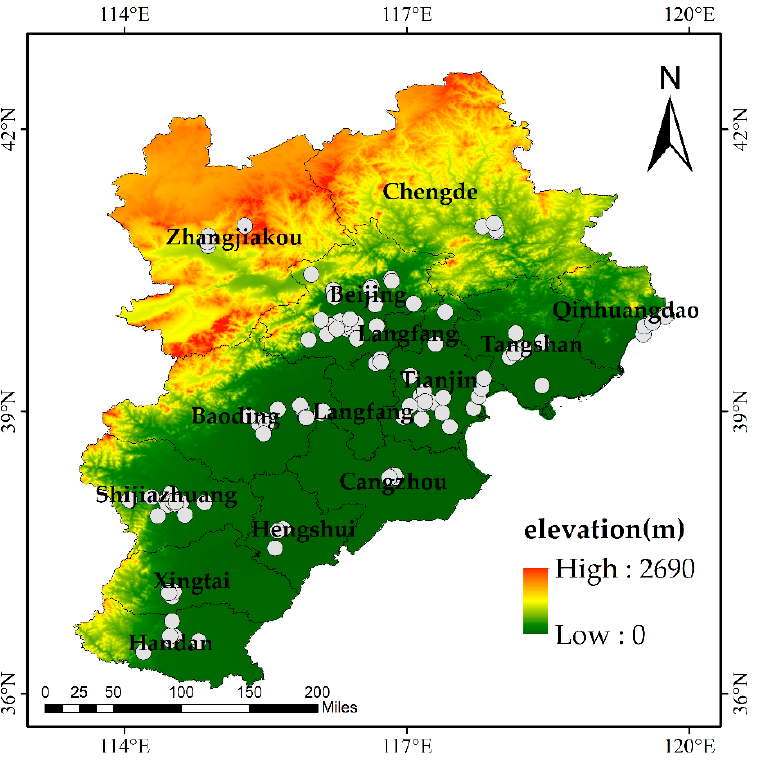
Figure 2. Elevation map of the BTH region. Ground PM 2.5 data were acquired from state-controlled ground stations (white dots). Table 1. Dataset statistics .